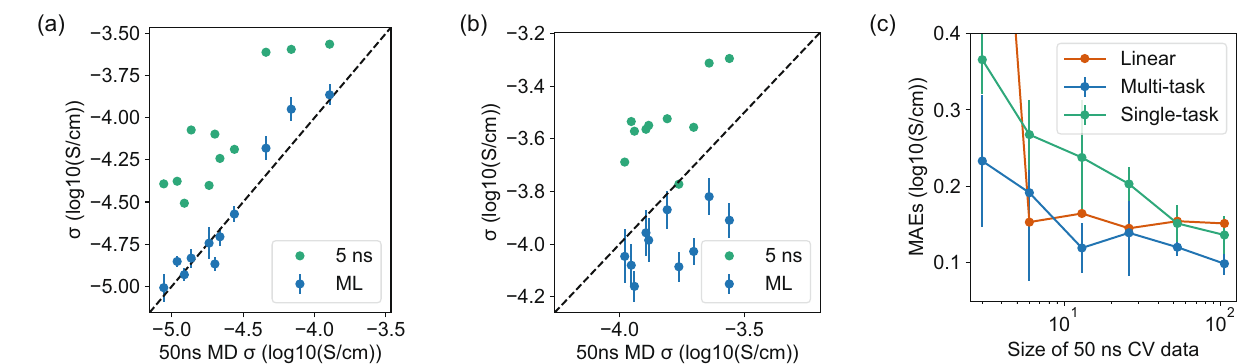
Fig. 3 Performance on correcting systematic errors. a , b Scatter plots showing the interpolation ( a ) and extrapolation ( b ) performance of the model on test data. Blue and green dots present the results of 5 ns MD simulations and ML predictions compared with 50 ns MD conductivities, respectively. The error bars represent the standard deviations of predictions from 10-fold cross-validation. c Change of interpolation performance with the different numbers of CV data. The red, blue, green lines denote the MAEs of linear correction, multitask model, and single-task model predicting 50 ns conductivity. The error bars represent the standard deviations of MAEs from